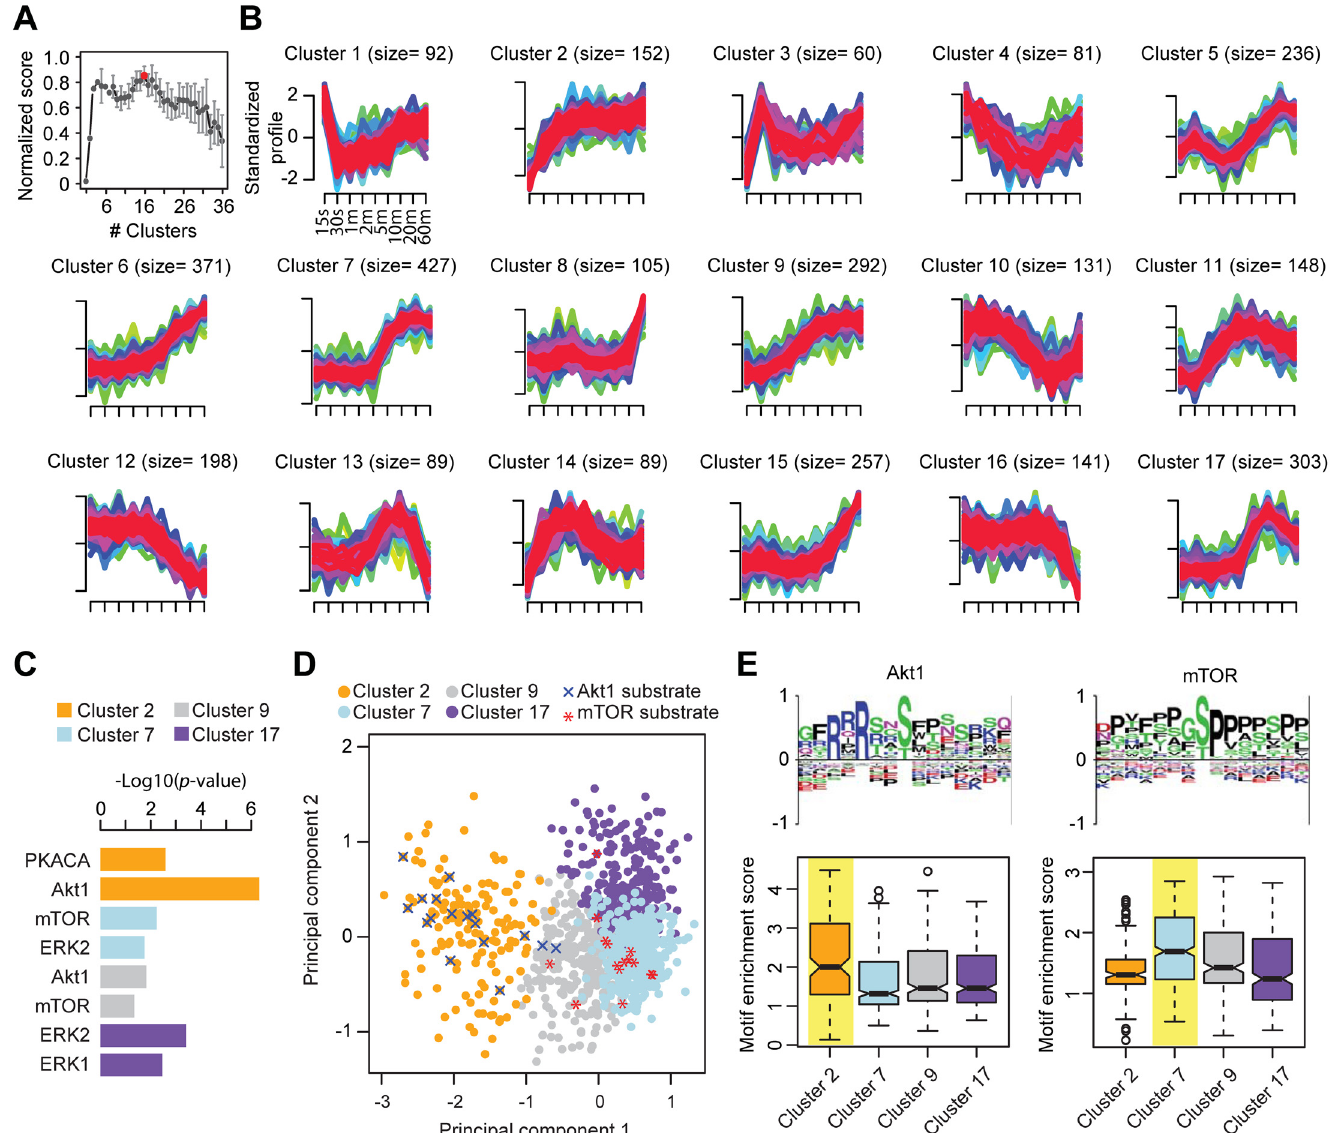
Fig 6. Optimal clustering and analysis of adipocytes phosphoproteomics data. CLUE's estimation of number of clusters. The number of clusters evaluated ranges from 2 to 36 and the optimal number of clusters, as estimated by CLUE, is highlighted in red. Visual representation of temporal profiles of phosphorylation sites within each cluster. Membership scores of all phosphorylation sites within a cluster is used to create color gradient from green to red correspond to lower to higher clustering confidence. Size: number of phosphorylation sites that have membership in that cluster. Bar plot showing kinases whose substrates are enriched within each cluster ( p -value < 0.05; Fisher ’ s exact test). Principal component analysis of the temporal profile of phosphorylation sites within clusters 2, 7, 9 and 17. Known substrates of Akt1 and mTOR kinases are highlighted in x and * , r e spectively. Motif